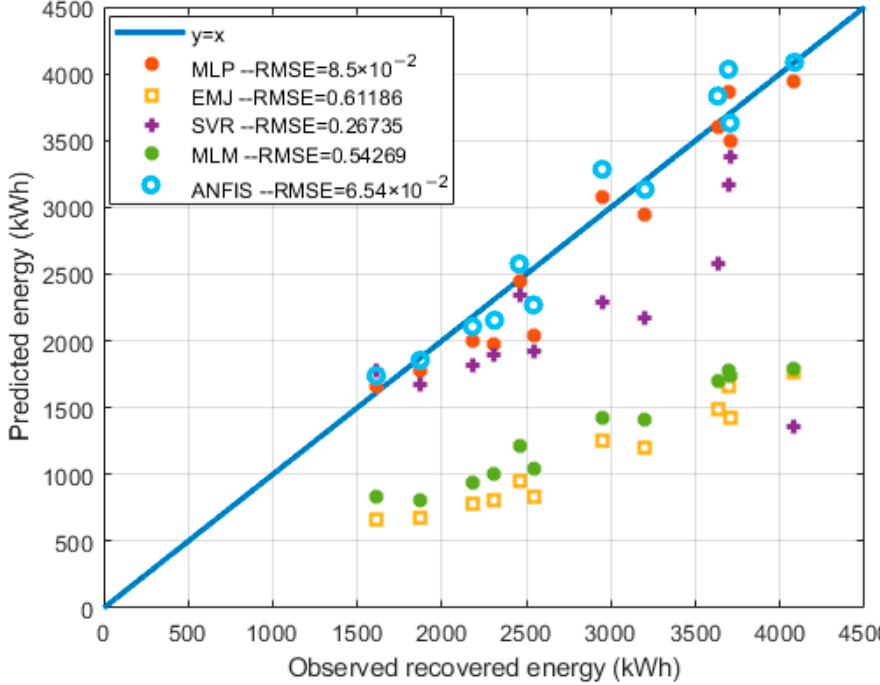
Figure 16. Cotonou: correlation between observed and estimated recoverable energy.